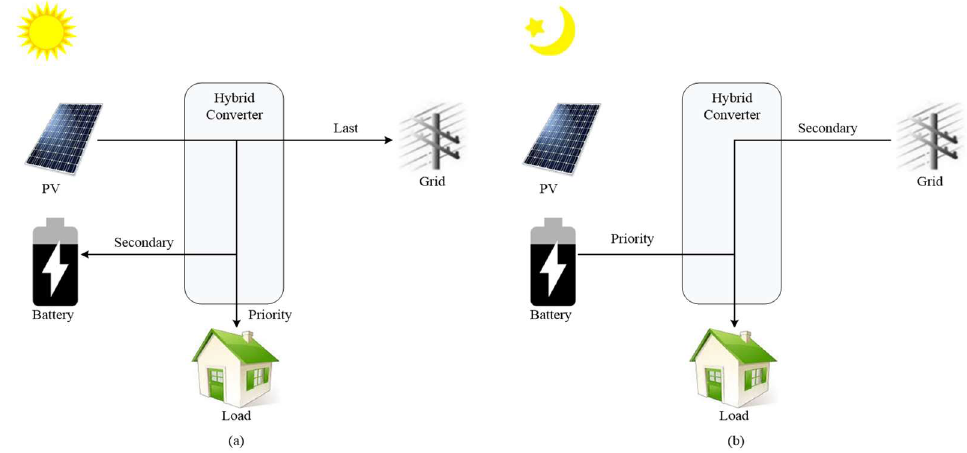
Figure 2. On-grid general mode: PV power is sufficient ( a ), PV power is insufficient ( b ).